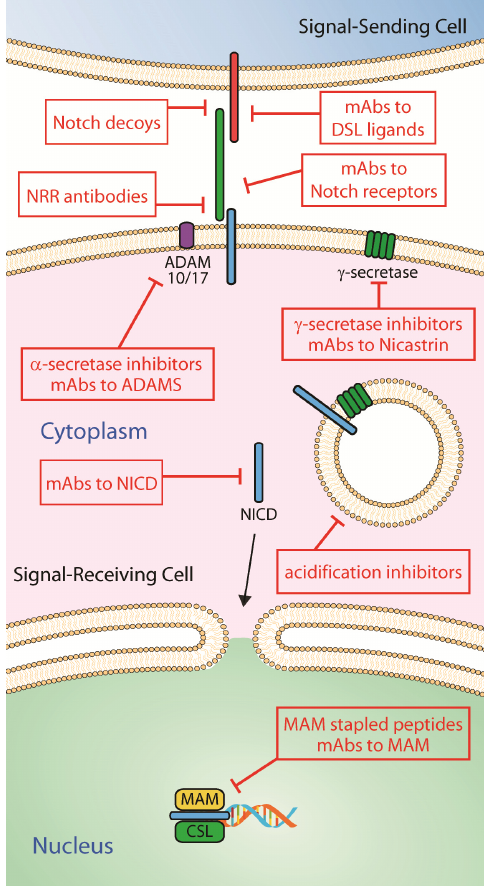
Figure 3. Therapeutic strategies to modulate Notch signaling activity. Potential therapeutic inhibitors to block Notch signaling activity include soluble decoy receptors, monoclonal antibodies (mAbs) to Notch receptors and mAbs to DSL ligands to disrupt / prevent receptor / ligand binding interaction; antibodies recognizing Notch proteins’ NRR domain, mAbs to ADAMS and α -secretase inhibitors to block S2 proteolytical processing; γ -secretase small molecule inhibitors and mAbs to Nicastrin to prevent S3 cleavage and NICD production; endosome acidification inhibitors to halt endosomal NICD release; blocking mAbs to inactivate NICD; and stapled peptides and mAbs to MAM to disrupt MAM / NICD / CSL